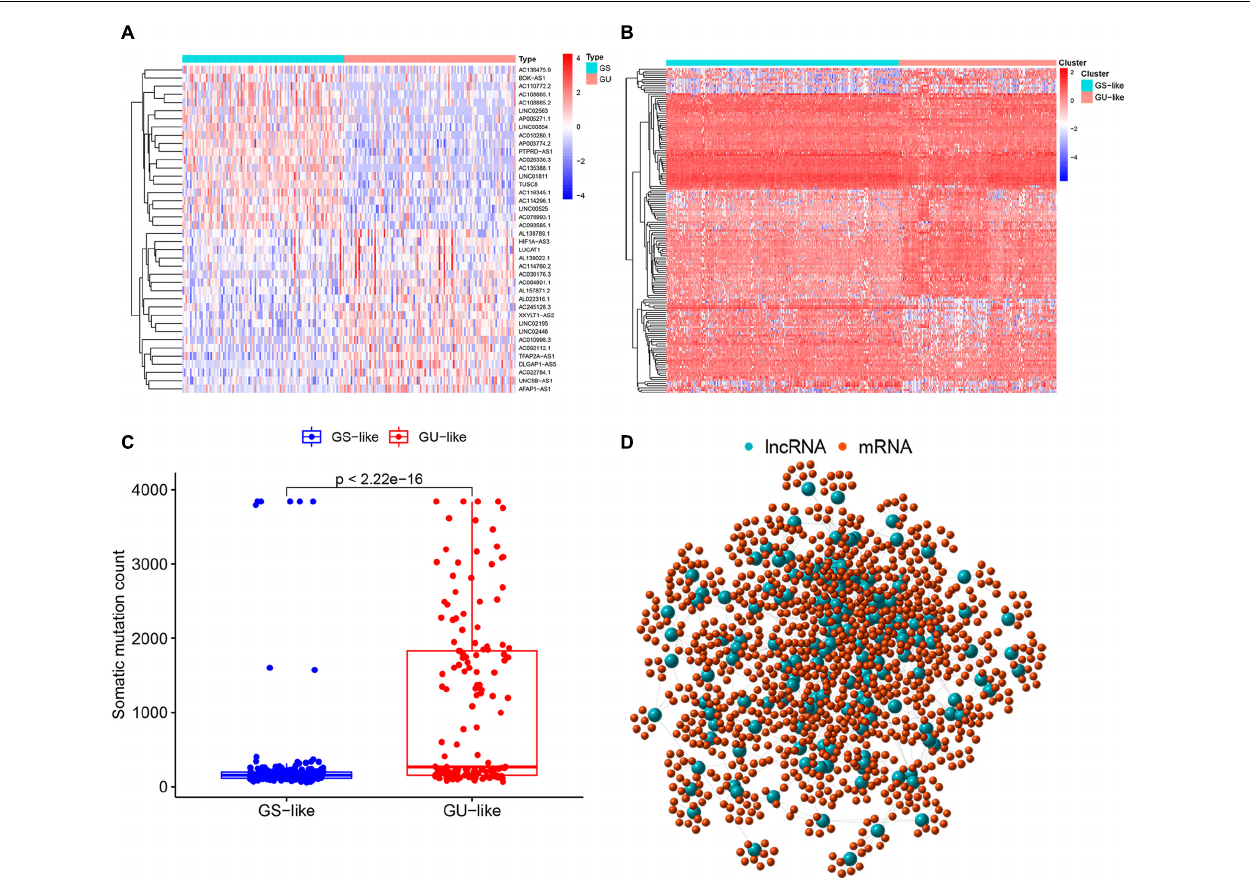
FIGURE 2 | Identification of genome instability-associated lncRNAs and the co-expression network. (A) Heatmap of the top 20 genome instability-associated lncRNAs expressing the most upregulation and downregulation. (B) Genome stable-like (GS-like) cluster and genome unstable-like (GU-like) cluster of patients arranged by the expression level of genome instability-related lncRNAs. (C) Boxplot of somatic mutations of the GS-like cluster and the GU-like cluster. The cumulative mutation count of the GU-like cluster was significantly higher than that of the GS-like cluster. (D) Co-expression network of genome instability-associated mRNAs and lncRNAs. The large blue circles represent lncRNAs, and the small red circles represent mRNAs.